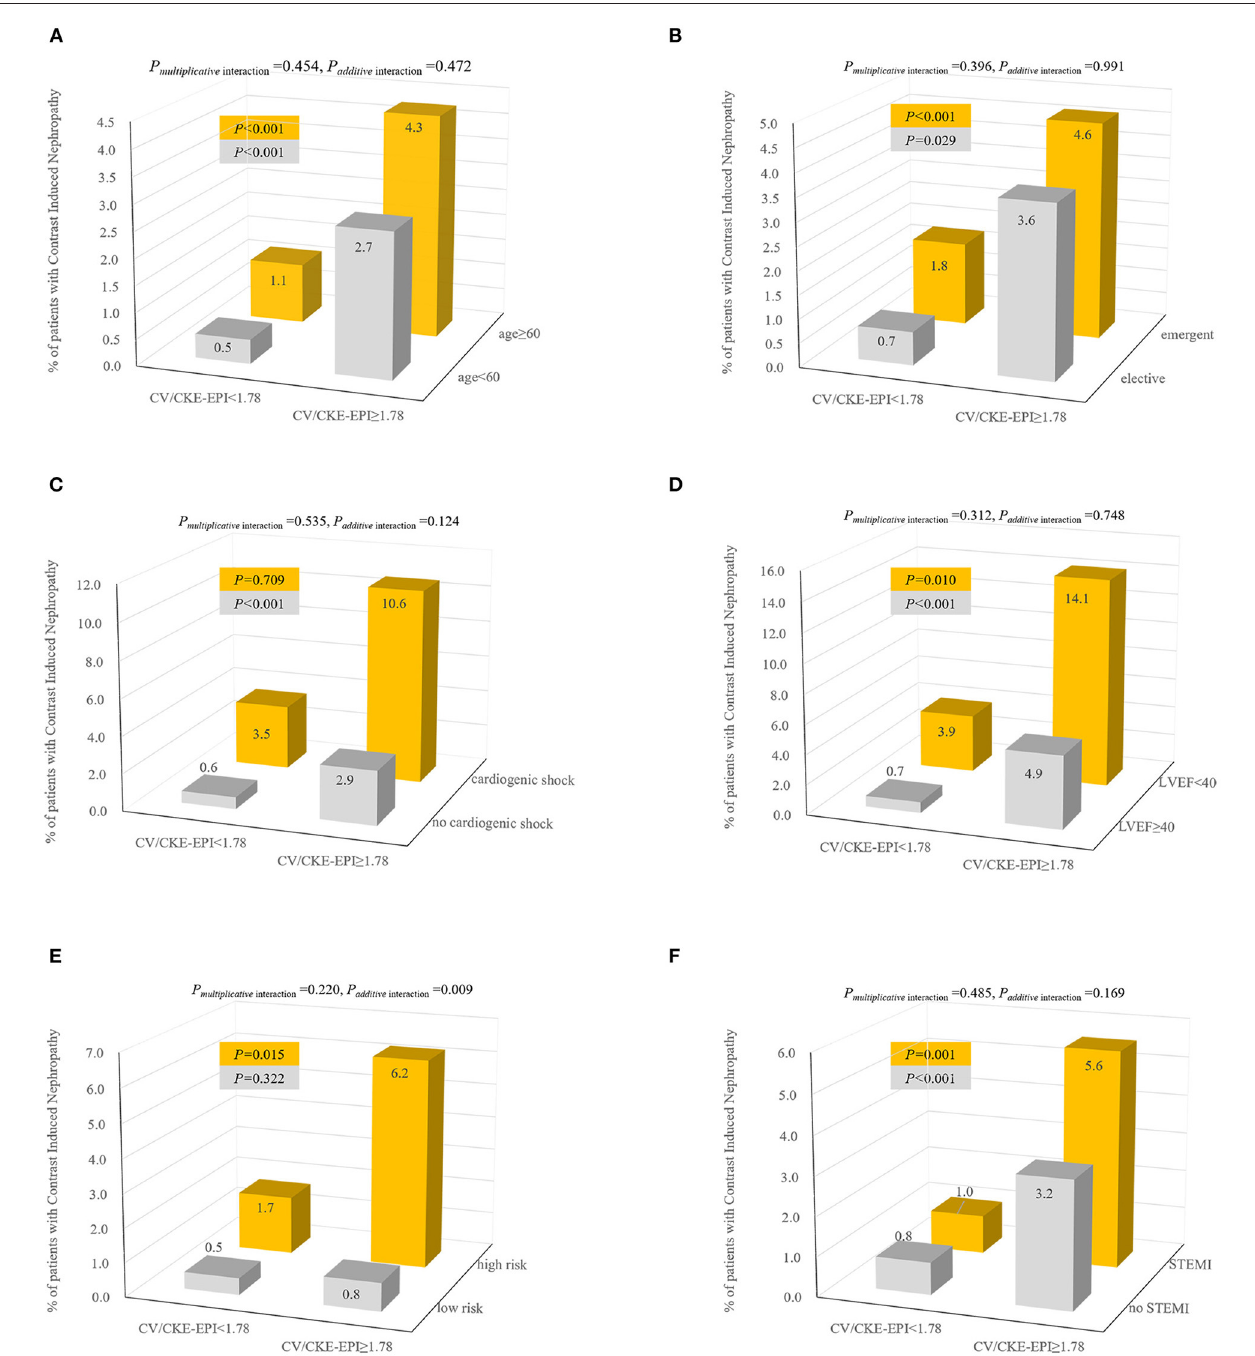
FIGURE 3 | Incidence and interaction of CIN according to joint distribution of CV/CKD-EPI cutoff 1.78 and patients with elder age (A) , elective PCI (B) , cardiogenic shock (C) , LVEF (D) , high-risk level of Mehran score (E) , and STEMI (F) . Interaction effects were calculated by multivariate model adjusted for covariates (forward stepwise method): age, anemia, cardiogenic shock, CHF, HF, hypoalbuminemia, peri-hypotension, peri-IABP, LVEF < 40%, preprocedural plasma glucose, min of hemoglobin, Hct, BUN, ALB, CK, CK-MB, diseased multivessel, PCI, number of stents, emergent PCI, Mehran integer score, and exceeding MACD. CV/CKD-EPI, contrast volume to chronic kidney disease epidemiology collaboration; CIN, contrast-induced nephropathy; LVEF, left ventricular ejection fraction; STEMI, segment elevated myocardial infarction.